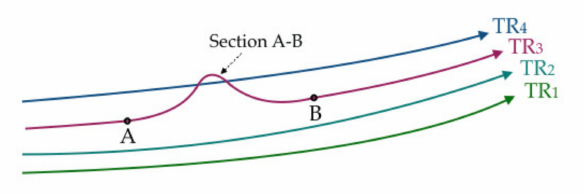
Figure 5. Example of an outlying sub-trajectory: section A–B of trajectory TR 3